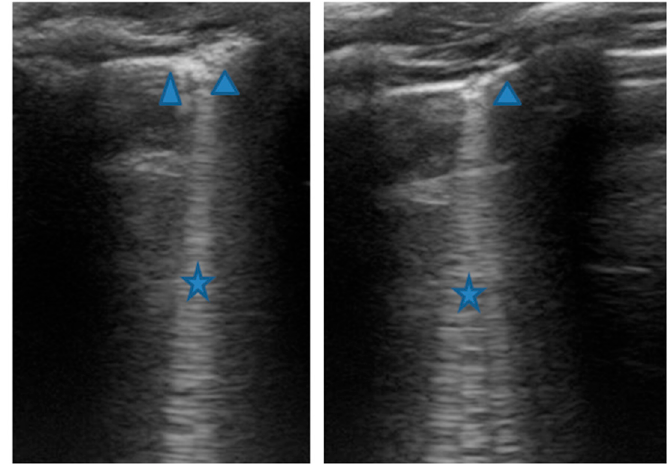
Figure 6. Grayscale lung ultrasound examination shows: sonographic interstitial syndrome (SIS), characterized by long confluent vertical artifacts (asterisks), associated with an irregular pleural line, and distributed over all the explored fields in an inhomogeneous way.